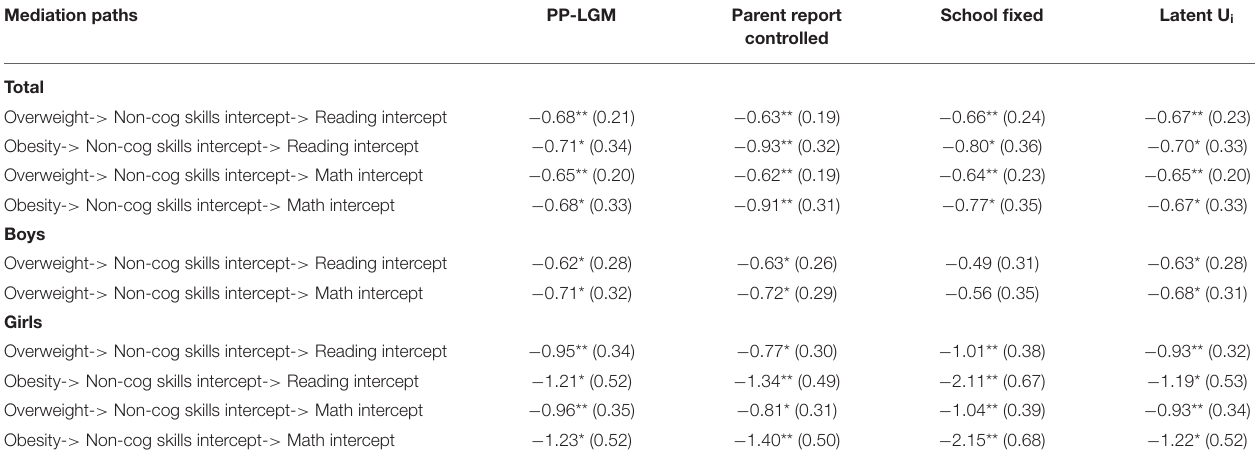
TABLE 4 | Sensitivity analysis for mediational analyses. Mediation